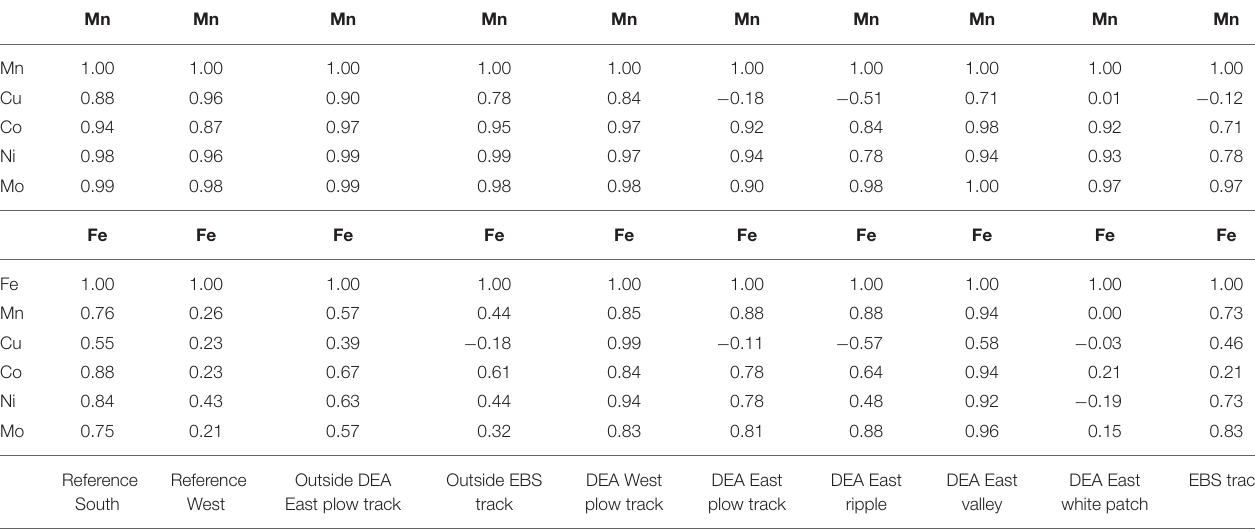
The entire profiles were